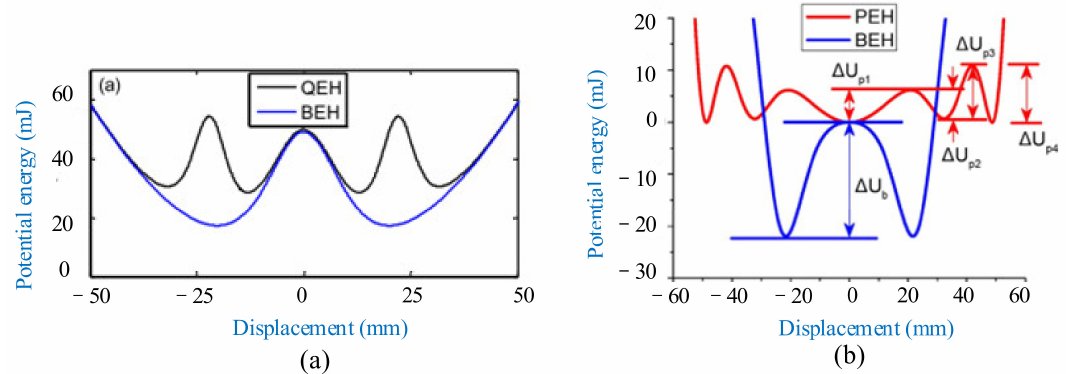
Figure 9. Potential energy shapes for: ( a ) Quadstable (QEH) and bistable (BEH) (reproduced with permission from [169]; published by Elsevier, 2016); and ( b ) pentastable (PEH) and bistable (BEH) (reproduced with permission from [174]; published by Elsevier B.V.,